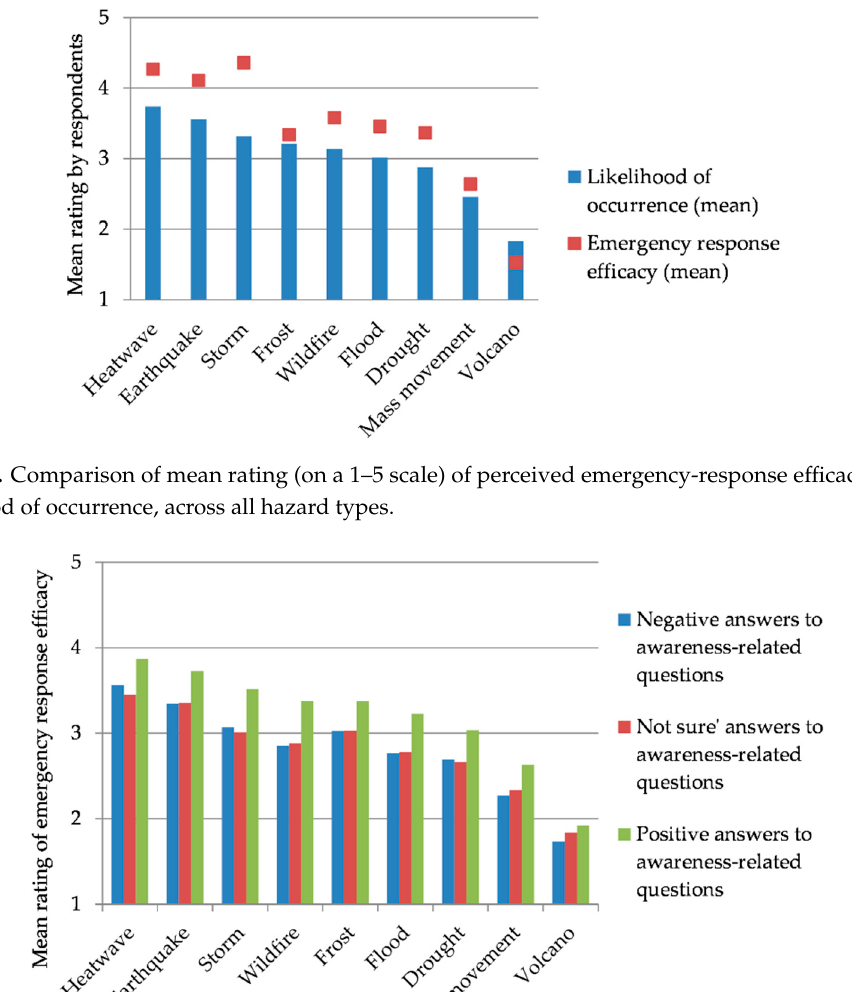
Figure 7. Comparison of mean rating of emergency response efficacy between positive, negative and “not sure” answers to the three awareness-related survey questions of Figure 3, across all hazard types.